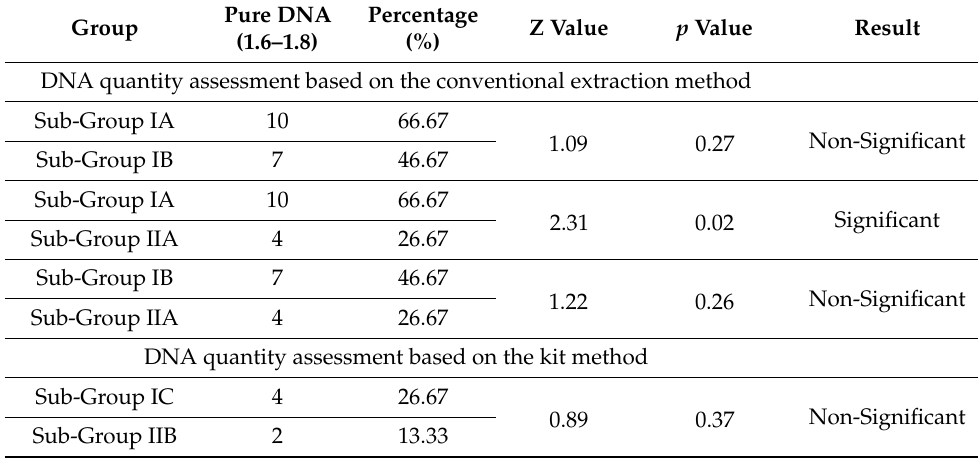
Table 8. Comparison of the mean quantity of DNA obtained between the methods from FFPET and FFT.